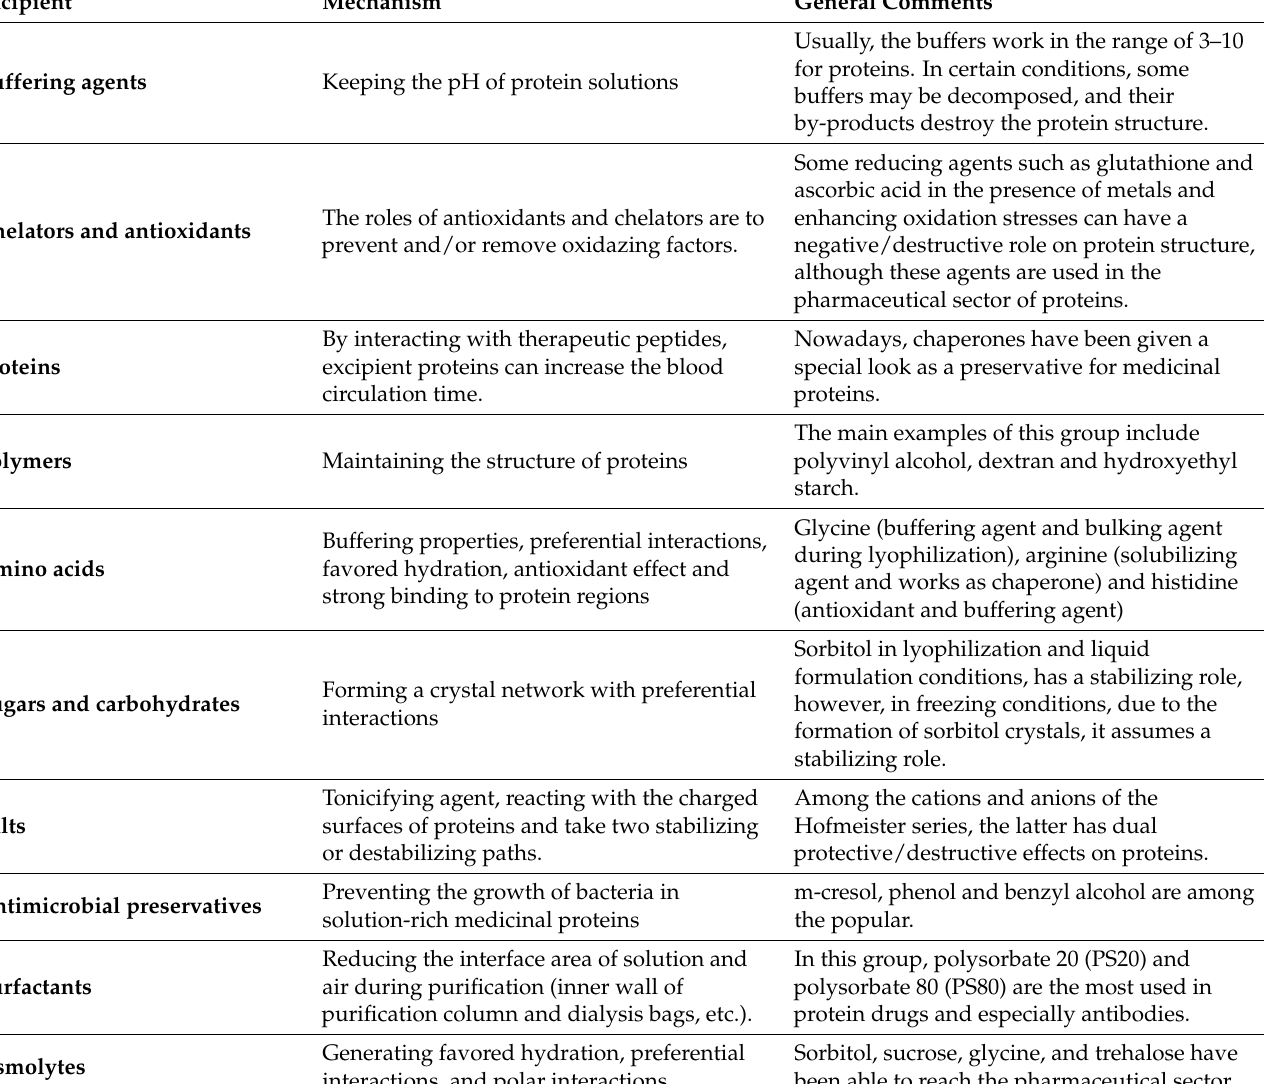
Table 6. Different types of additives for the formulation of protein and peptide drugs